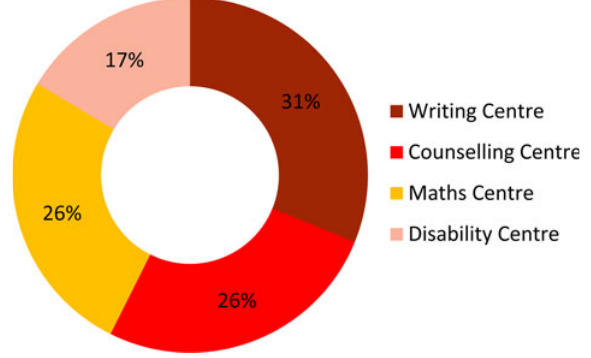
Fig. 12. University services